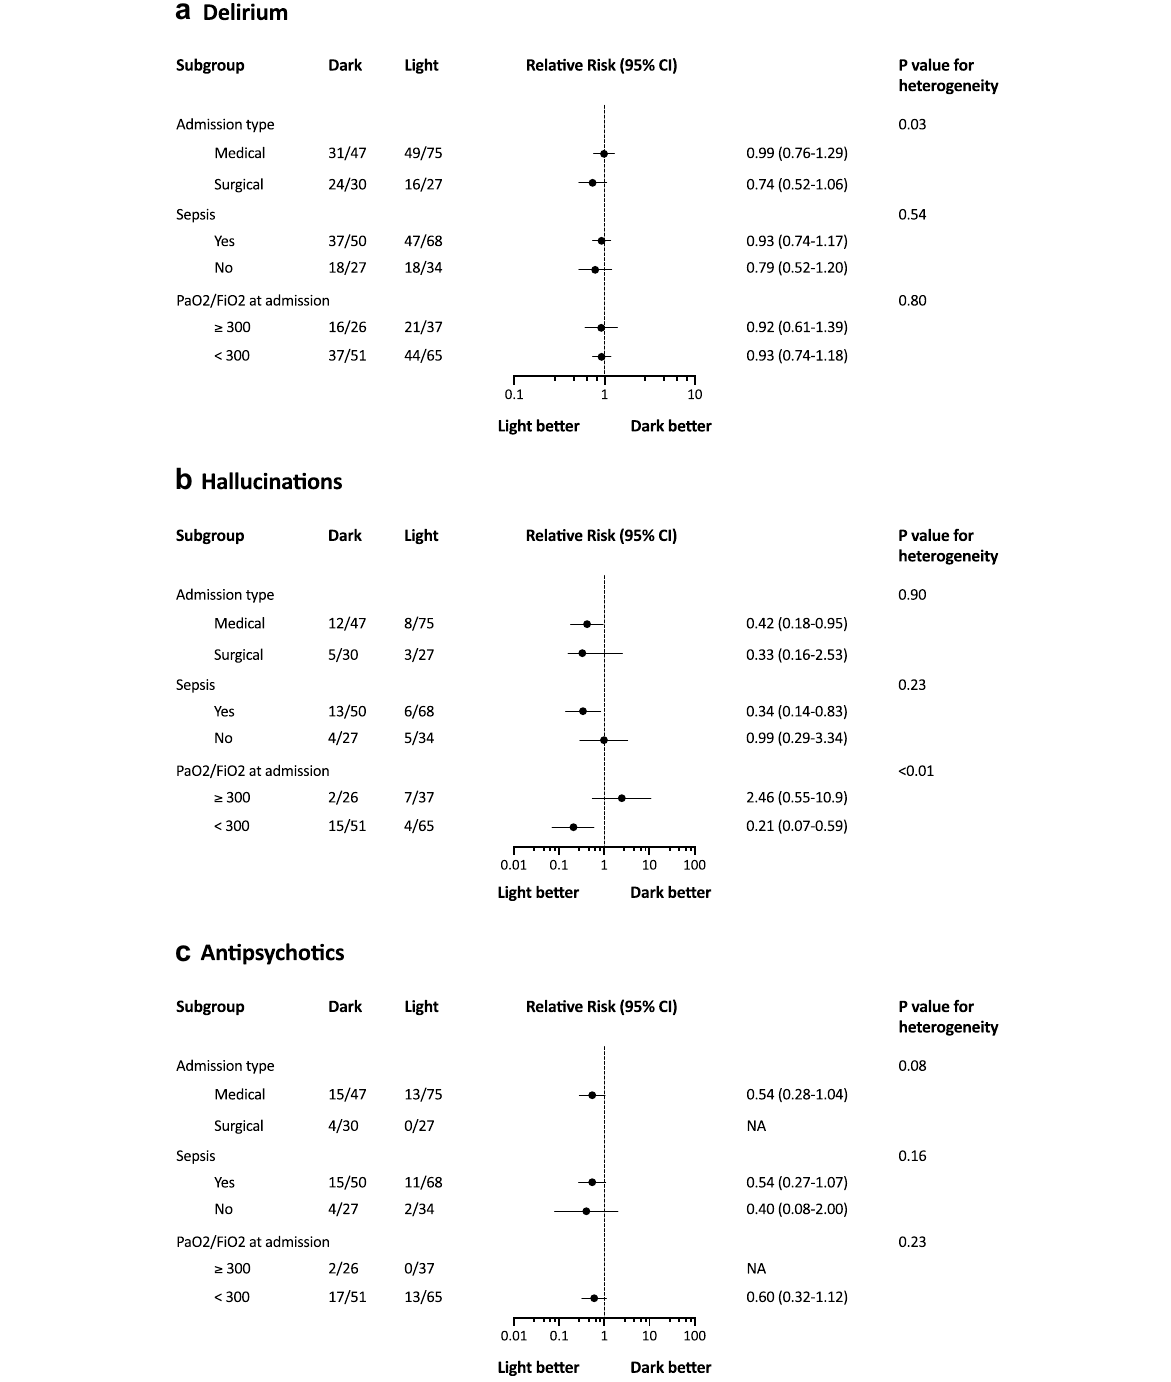
Fig. 1 Effects of admission to a room with natural light exposure on delirium outcomes, post hoc subgroup exploratory analyses. a Delirium, measured on the intensive care delirium screening checklist (ICDSC); b hallucinations item of the ICDSC; c severe agitation episodes intervened with antipsychotics during ICU stay. LIGHT indicates admission to a room with natural light exposure via windows. DARK indicates admission to a room without natural light exposure. ICU intensive care